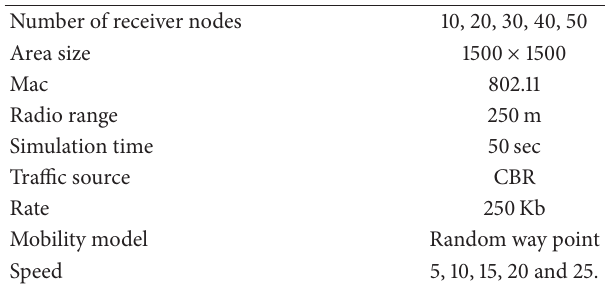
Table 1: Simulation